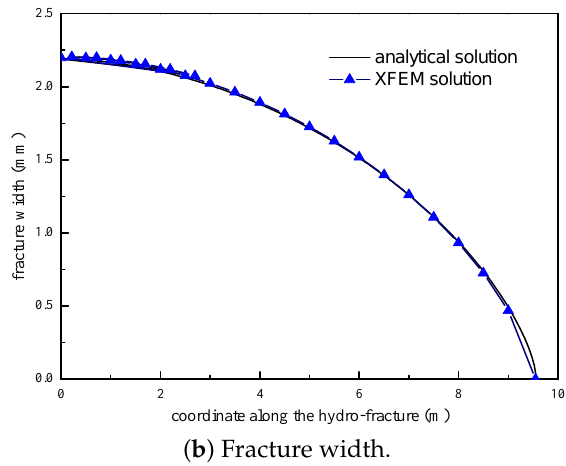
Figure A1. Results of the XFEM technique and of the analytical